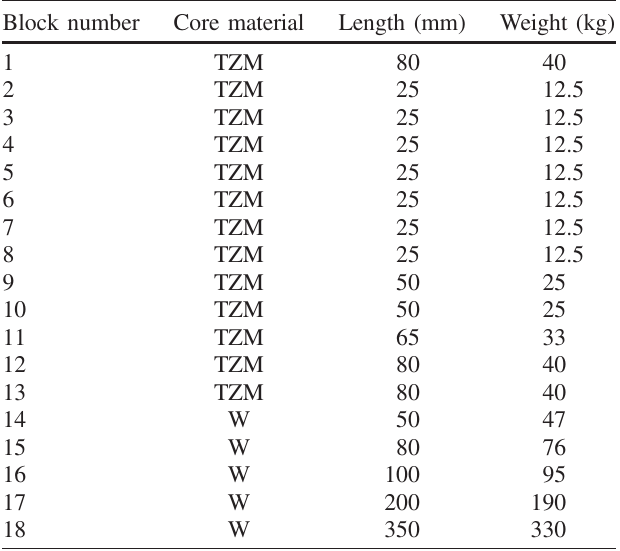
TABLE II. Summary of the BDF final target cylinder longi- tudinal thickness and